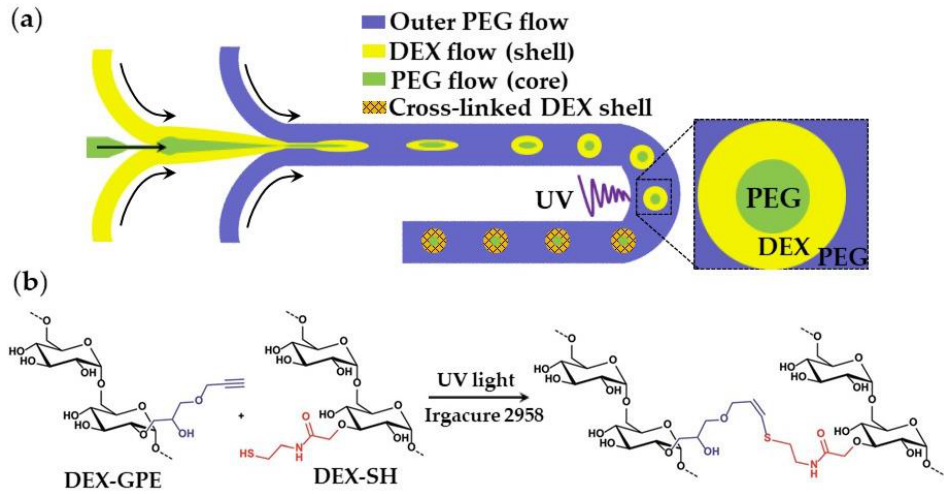
Figure 31. ( a ) Formation of microgels with a liquid PEG core and a solid DEX shell by